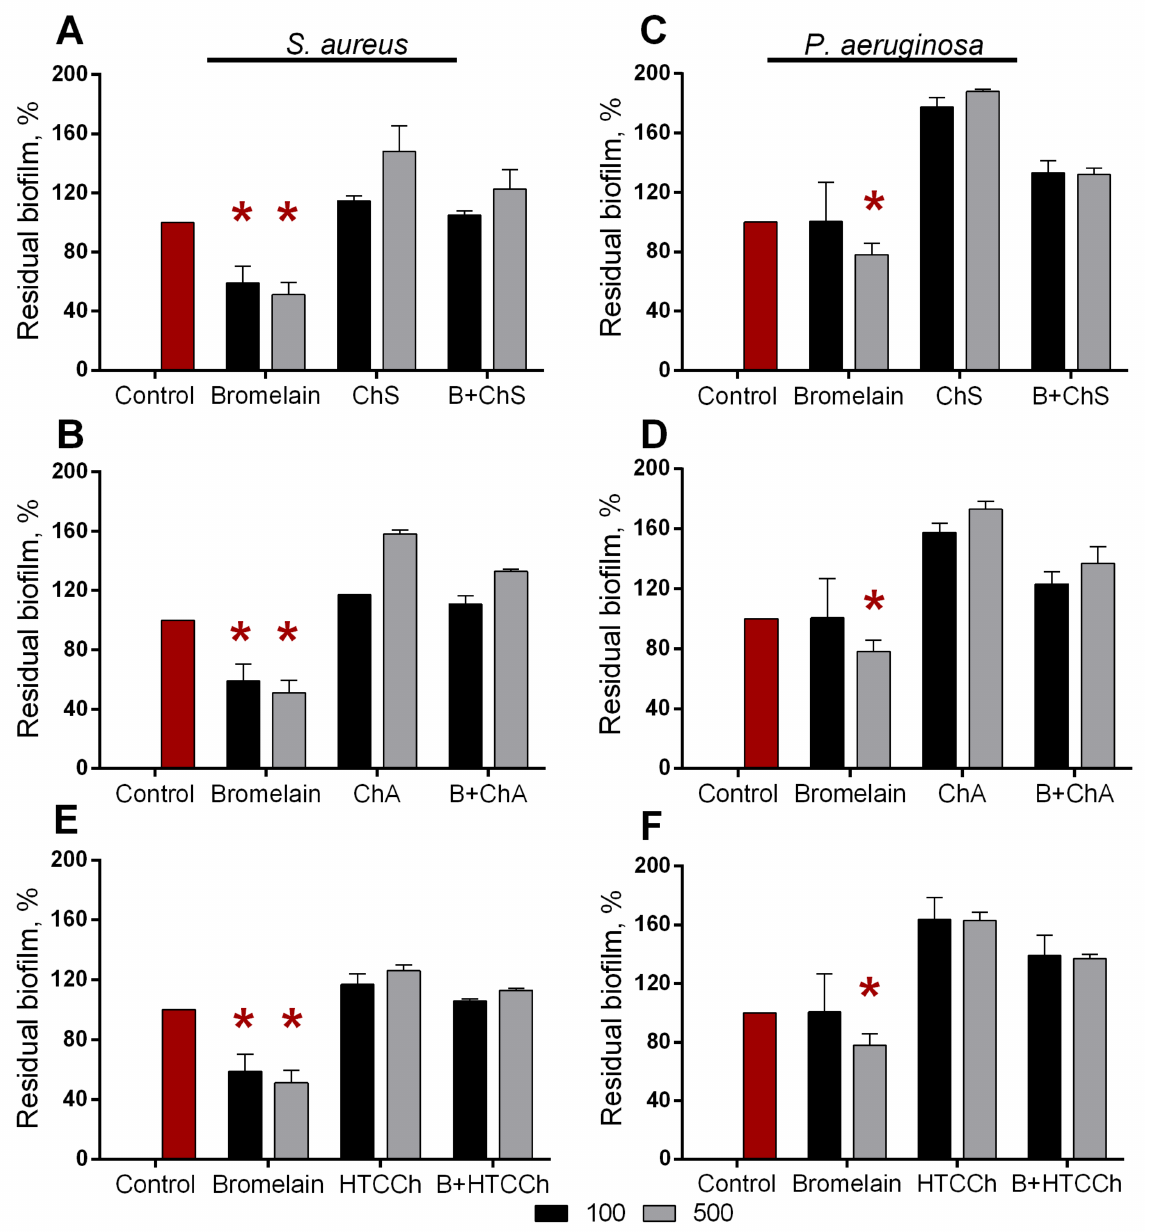
Figure 8. Effect of soluble bromelain and enzyme immobilized on N -(2-hydroxypropyl)-3- trimethylammonium chitosan (HTCCh), chitosan sulfate (ChS), and chitosan acetate (ChA) on ( A , B , E ) S. aureus and ( C , D , F ) P. aeruginosa biofilms. The 48 h old biofilms were gently washed and treated for 3 h with enzymes at concentrations of 0.1 and 0.5 mg · mL − 1 . The amount of heteroge- neous enzyme corresponded to 0.1 and 0.5 mg · mL − 1 of the soluble enzyme; pure carriers in similar concentrations were taken as a negative control. Residual biofilms were quantified with crystal violet staining. Asterisks (*) denote statistically significant differences between untreated and treated samples ( p < 0.05). Untreated wells were considered to be